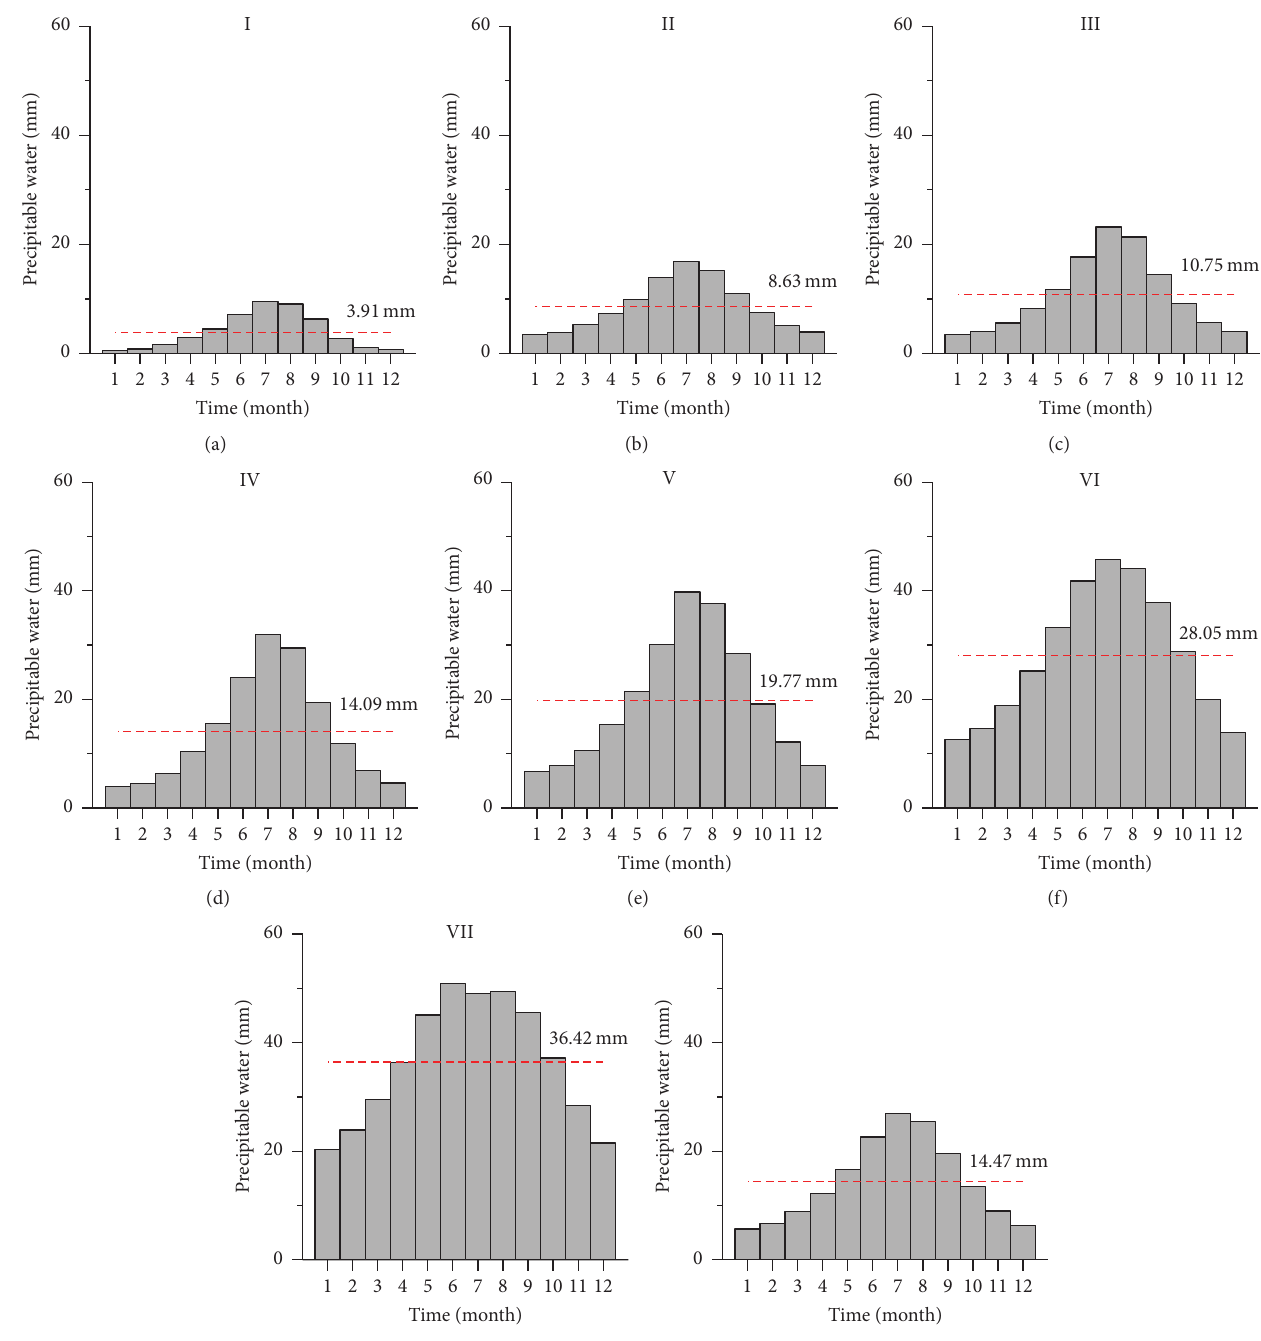
Figure 7: Monthly average PW from January to December during 1951 to 2015. (a)–(f) denote monthly average PW from region I to region VII and (h) represents the monthly average PW in China. The red dashed line in (a)–(h) depicts the average annual precipitation atmospheric precipitable amount in each region.